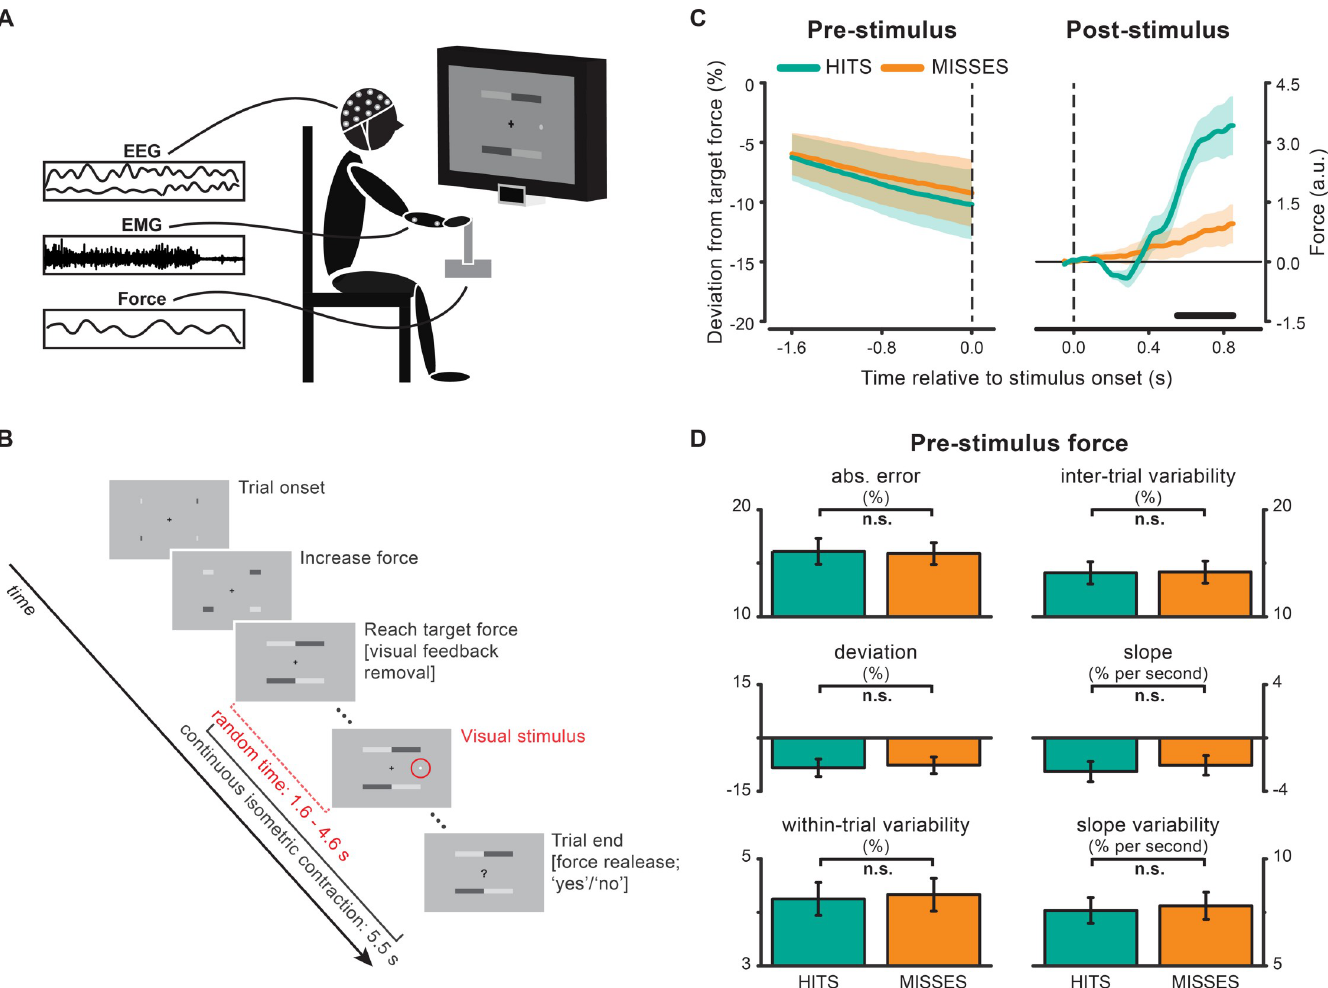
Fig 1. Experimental setup, procedure, and behavioral results. (A) EEG, EMG, and force were recorded while participants performed 2 tasks concurrently: visual detection and right wrist abduction to push an isometric joystick’s handle towards one’s own body. (B) Visual feedback of the force (4 horizontal bars elongating towards the center of the screen) was provided until participants reached the target force level (see Methods). Afterwards, participants were required to fixate and maintain stable contraction for 5.5 seconds without visual feedback. During continuous contraction, a near-threshold visual dot could appear 7.5˚ to the right of fixation and at a random time between 1.6 and 4.6 seconds (no stimulus was presented in 15% of trials). Trial end was signaled by a question mark prompting participants to release the contraction and report verbally whether they had seen or not seen the visual stimulus. (C) Force time courses in the pre- (left) and post- (right) stimulus period for hits and misses trials. Shaded areas represent ± 1 SEM. The black horizontal line indicates the time interval (0.55–0.85 seconds) belonging to the cluster that survived cluster-based permutation statistics for the hits–misses contrast. (D) Motor performance in the − 1.6- to 0-second window before stimulus presentation quantified as absolute (error) and relative (deviation) percentage difference from target force, intertrial and within-trial force variability, slope, and slope variability. Error bars represent ± 1 SEM. For the underlying data, see https://osf.io/VSZCB/. a.u., arbitrary units; EEG, electroencephalography; EMG, electromyography; n.s., non-